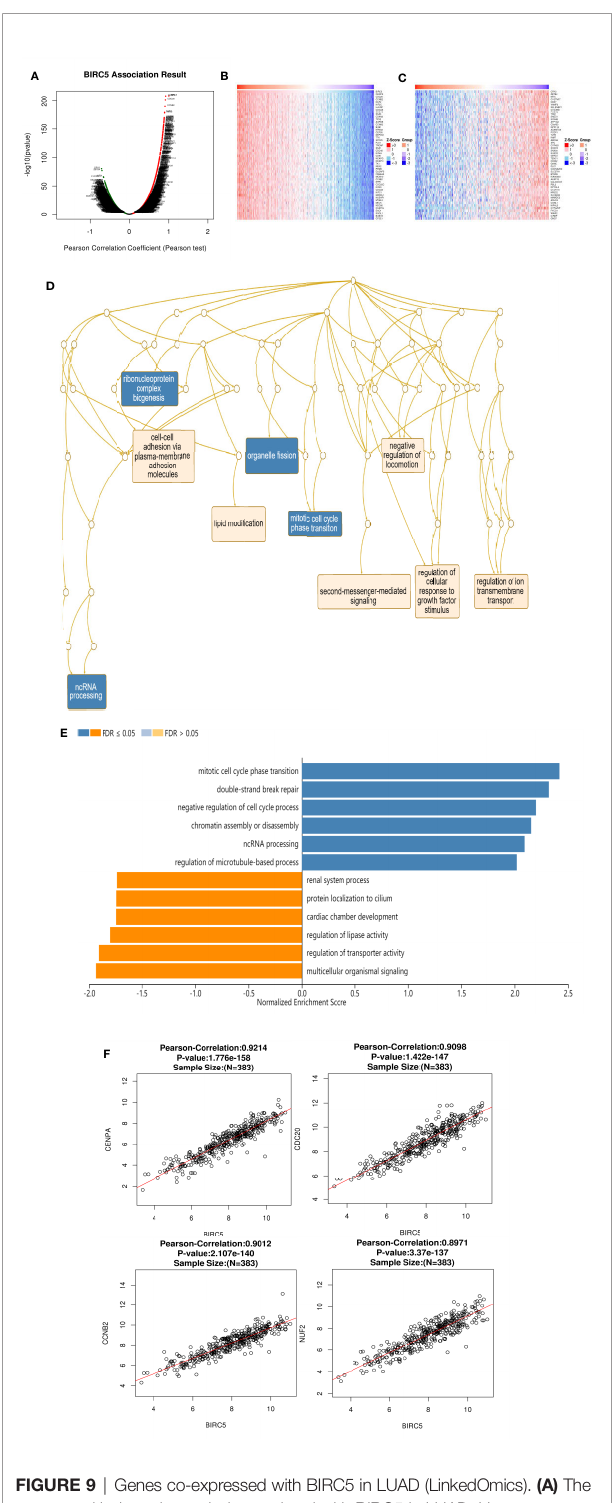
FIGURE 9 | Genes co-expressed with BIRC5 in LUAD (LinkedOmics). (A) The genes positively and negatively correlated with BIRC5 in LUAD. Heat maps showing top 50 genes positively (B) and negatively (C) correlated with BIRC5 in LUAD. Red indicates positively correlated genes and blue indicates negatively correlated genes. (D) Signi fi cantly enriched GO annotations and KEGG pathways of BIRC5 in TCGA cohort (E) . The correlation between the hub genes and BIRC5 in LUAD (F) .